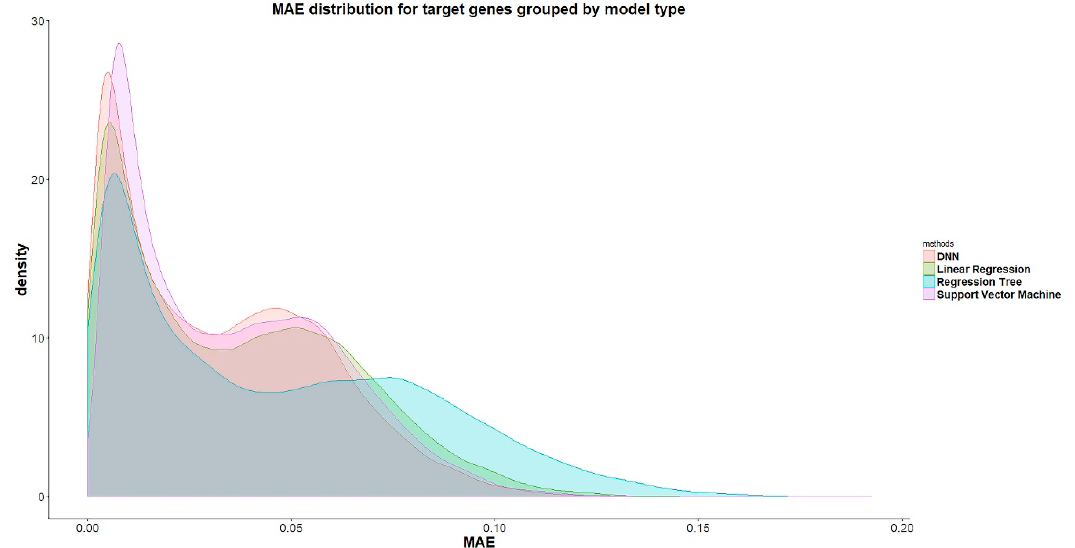
Figure 4. The density plots of the MAE by LR, RT, SVM, and D-GPM for the MBV-te.